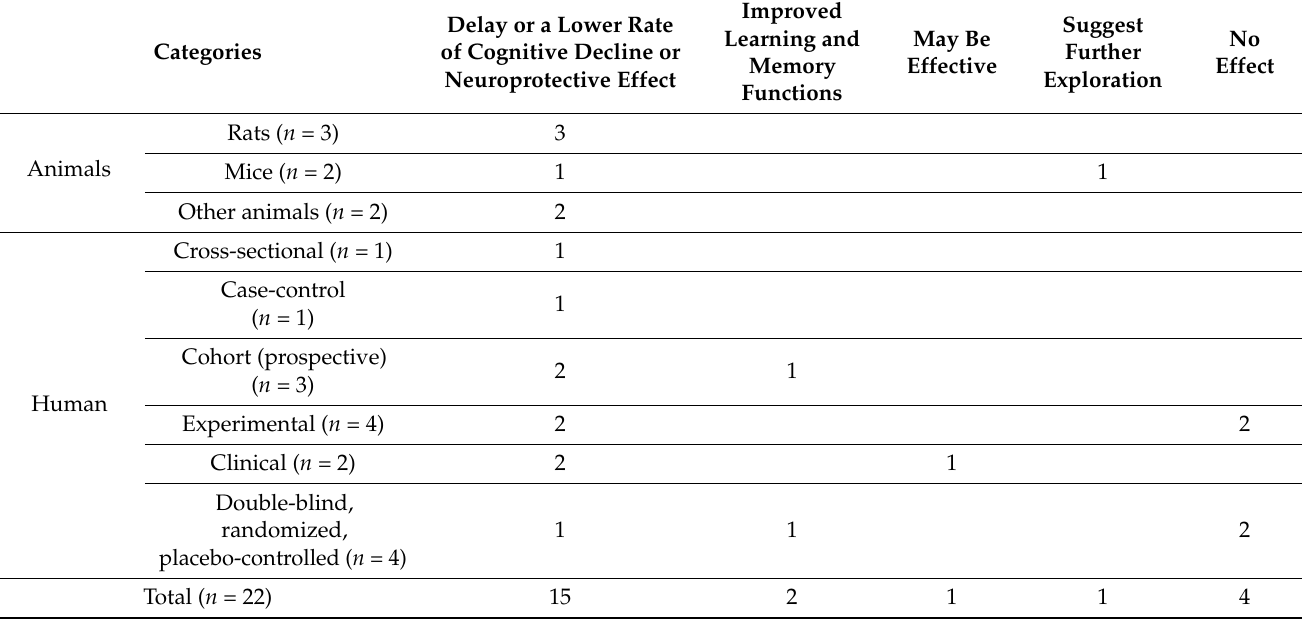
Table 2. Summary results of all studies in the review ( n =